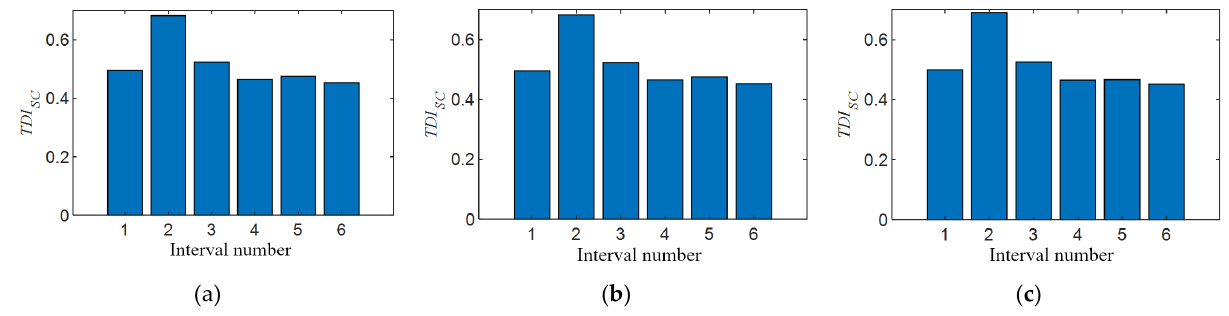
Figure 21. TDI SC validation at different vehicle masses: ( a ) TDI SC of stiffness damage in the second interval when load is 8 counterweight blocks; ( b ) TDI SC of stiffness damage in the second interval when load is 12 counterweight blocks; and ( c ) TDI SC of stiffness damage in the second interval when load is 16 counterweight blocks.